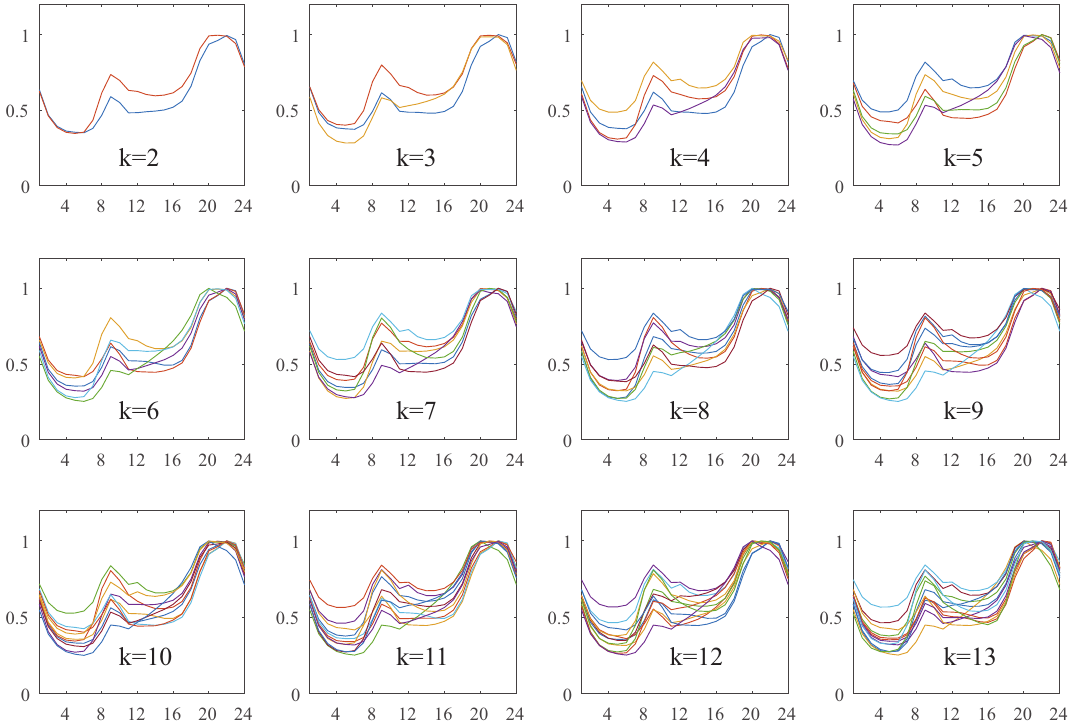
Figure 13. A comparison for the decision maker of k cluster number (residential area load